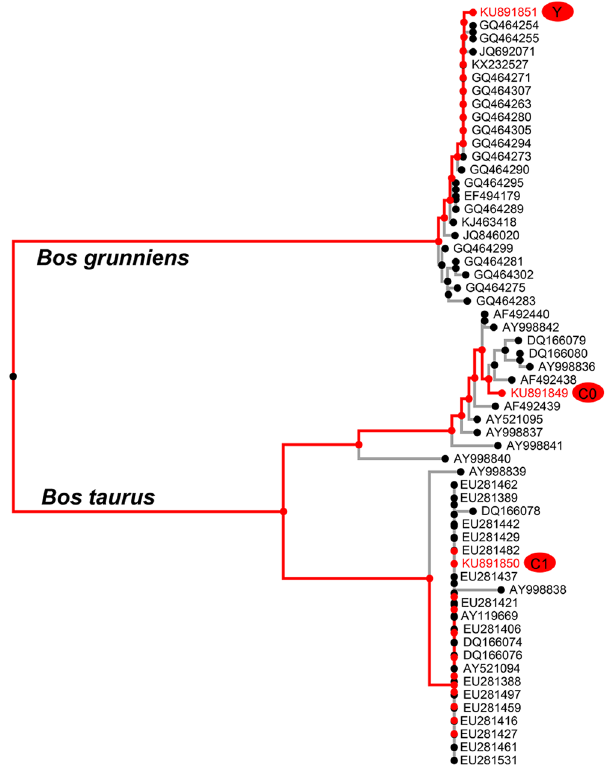
Figure 1. Relationship of the three bovine primary cells of yak, Holstein and Luxi revealed by mitochondrial control sequences. Codes indicating GenBank entries, red codes indicating primary cells of yak (Y), Holstein (C0) and Luxi